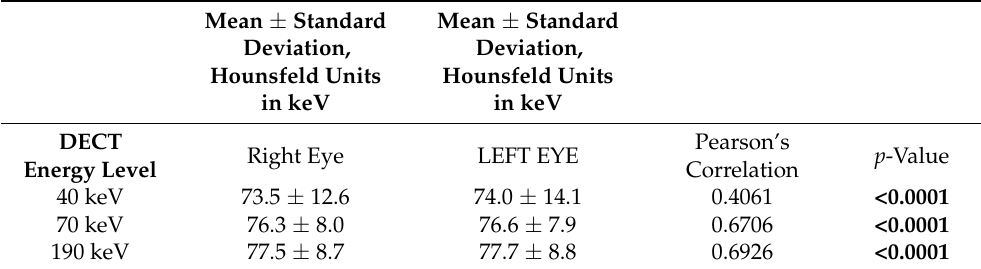
Table 2. Correlation of right and left eye attenuation measurements on Dual-Energy Computed Tomography in 95 pairs of eyes in 95